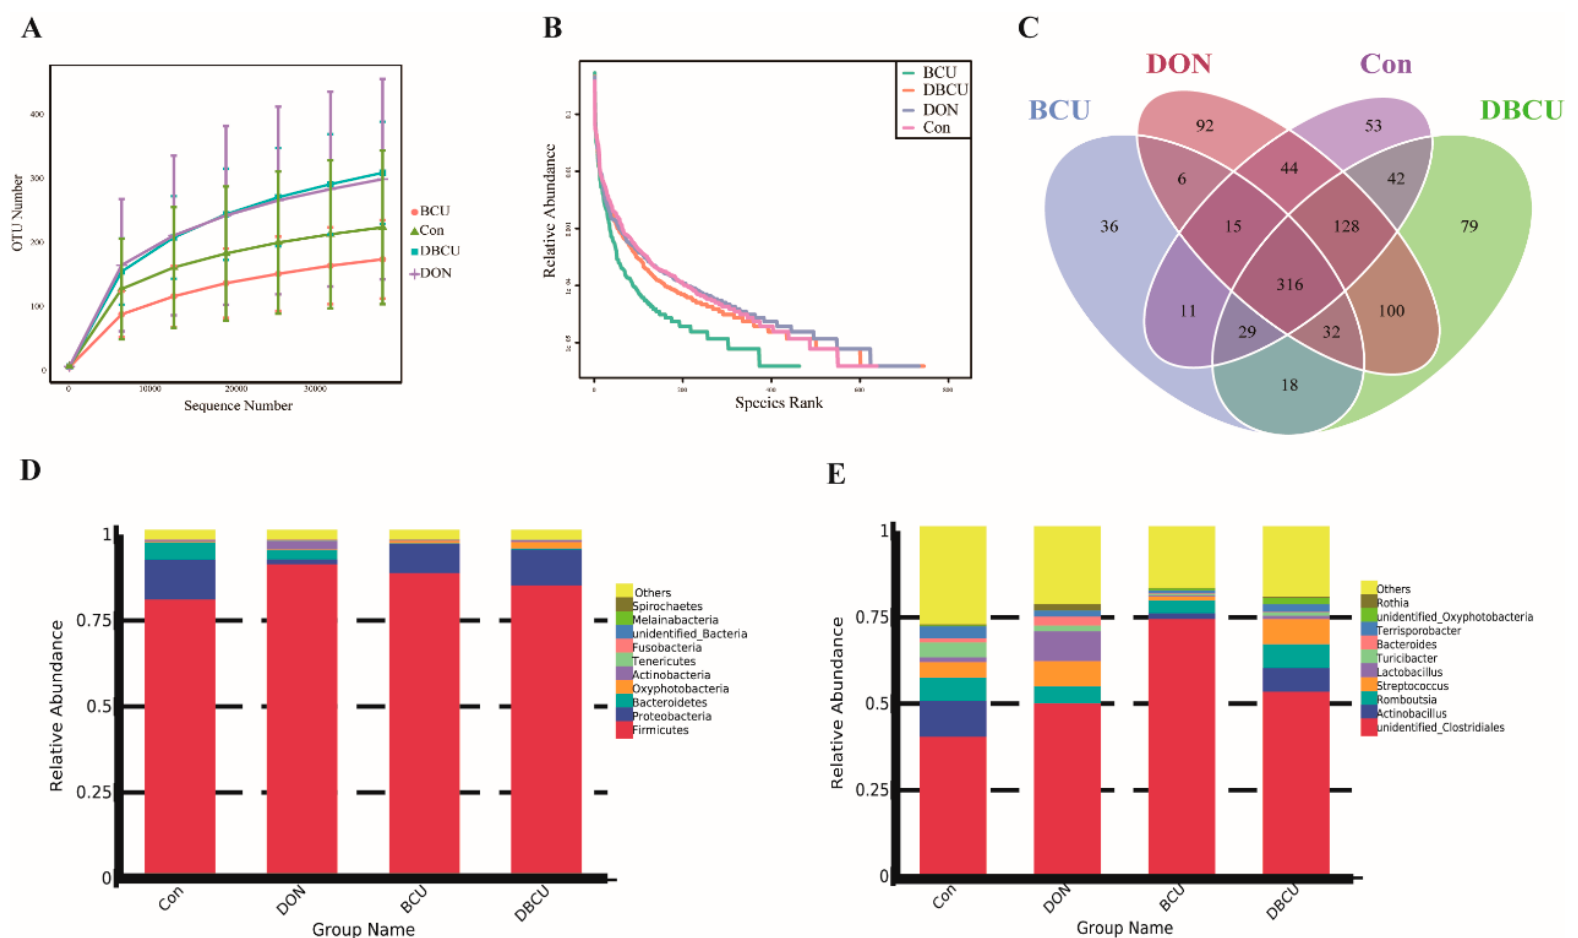
Figure 1. Sequencing quality analysis and the composition of intestinal microbiota. ( A ) Rarefaction curve; ( B ) rank abundance curve; ( C ) Venn diagrams for bacterial OTUs (operational taxonomic units); ( D ) taxonomic composition of the ileac digesta at the phylum level; ( E ) taxonomic composition of the ileac digesta at the genus level. Basal diet (Con); 4 mg deoxynivalenol (DON)/kg diet (DON); 5 g baicalin-copper complex (BCU)/kg diet (BCU); 5 g BCU/kg with 4 mg DON/kg diet (DBCU). 2.2. Gut Microbiota Diversity The observed species indicated the number of species contained in the sample. Notably, dietary BCU supplementation lead to an increase in observed species (Figure 2A). The figure shows that no differences were detected in diversity indices (Shannon), but there was an increase in richness estimators (Chao1 and Ace) in the dietary BCU supplementation groups (Figure 2B–D). Based on the binary Jaccard distance, we applied principal coordinates analysis (PCoA) plots to evaluate the differences in beta-diversity. Dietary DON supplementation caused gradual and significant segregation changes in the intestinal microbiota. The Con group and the BCU group clustered together, which suggested that dietary BCU supplementation had less effect on the intestinal composition of normal piglets (Figure 2E). Consistently, nonmetric multidimensional scaling (NMDS) plots based on the binary Jaccard distance confirmed the effect of DON on the intestinal microbiota (Figure 2F). The figure shows that the microbial community in DON- supplementation piglets was more closely related to the DBCU group (Figure 2G), which suggested that DON had a greater impact on gut microbes than BCU.